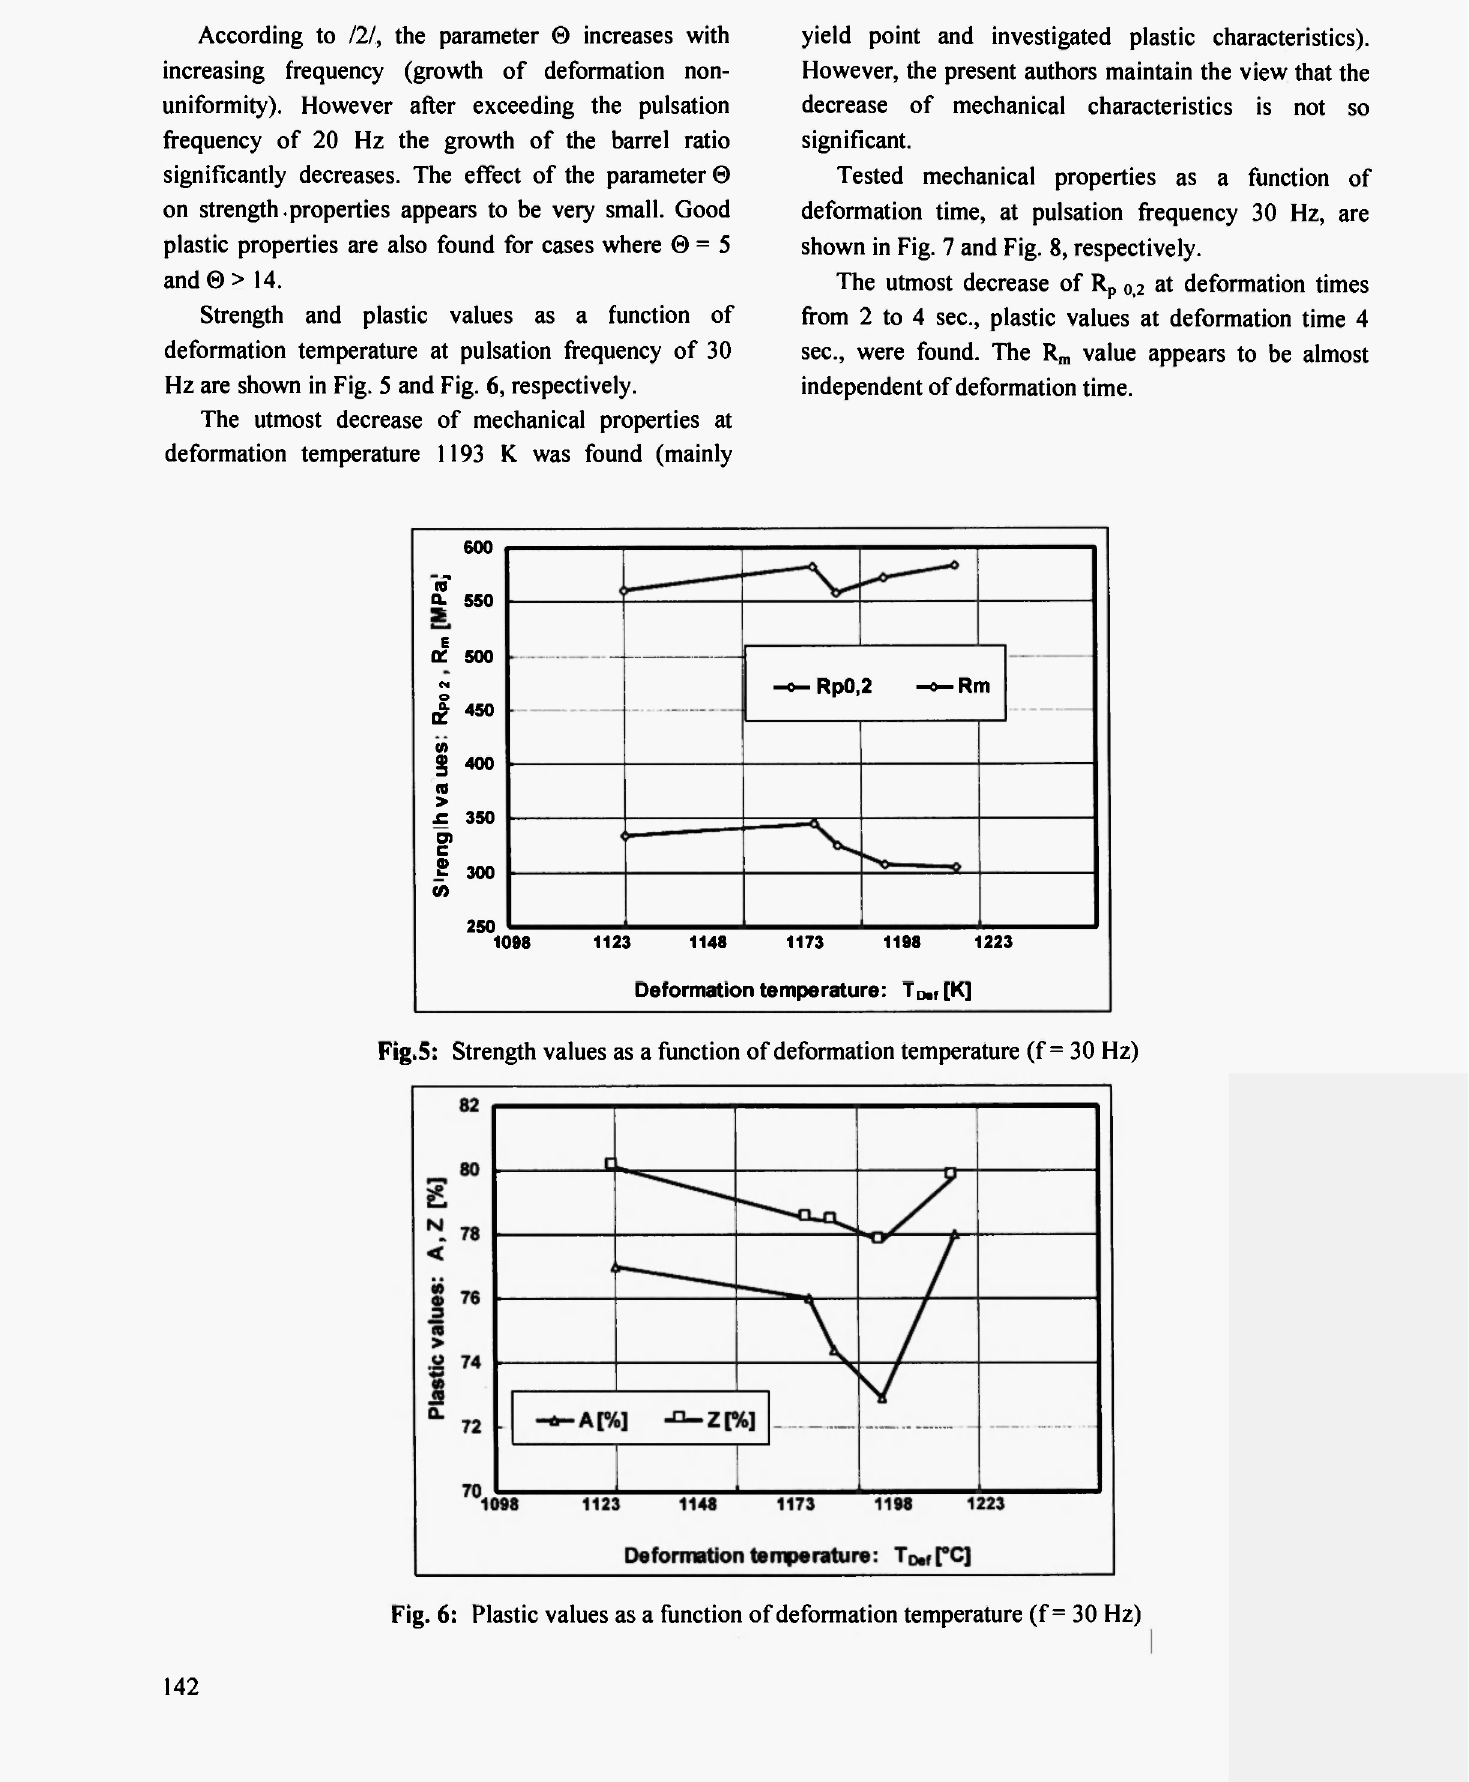
Fig. 6: Plastic values as a function of deformation temperature (f = 30